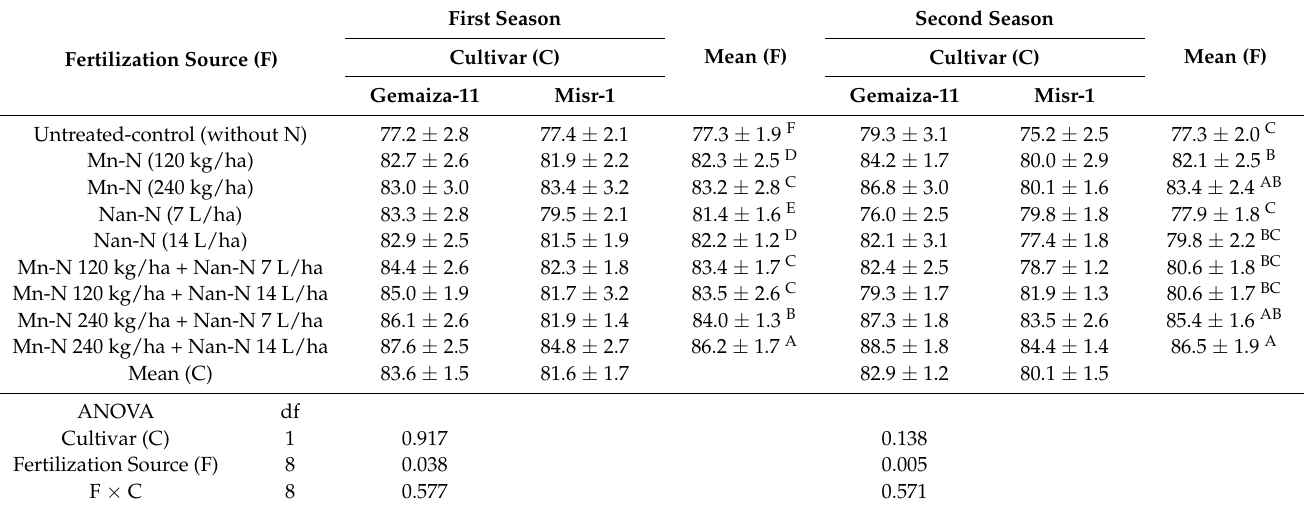
Table 2. Impact of nano and mineral nitrogen fertilizers on the plant height (cm) of two wheat cultivars during the 2019/2020 and 2020/2021